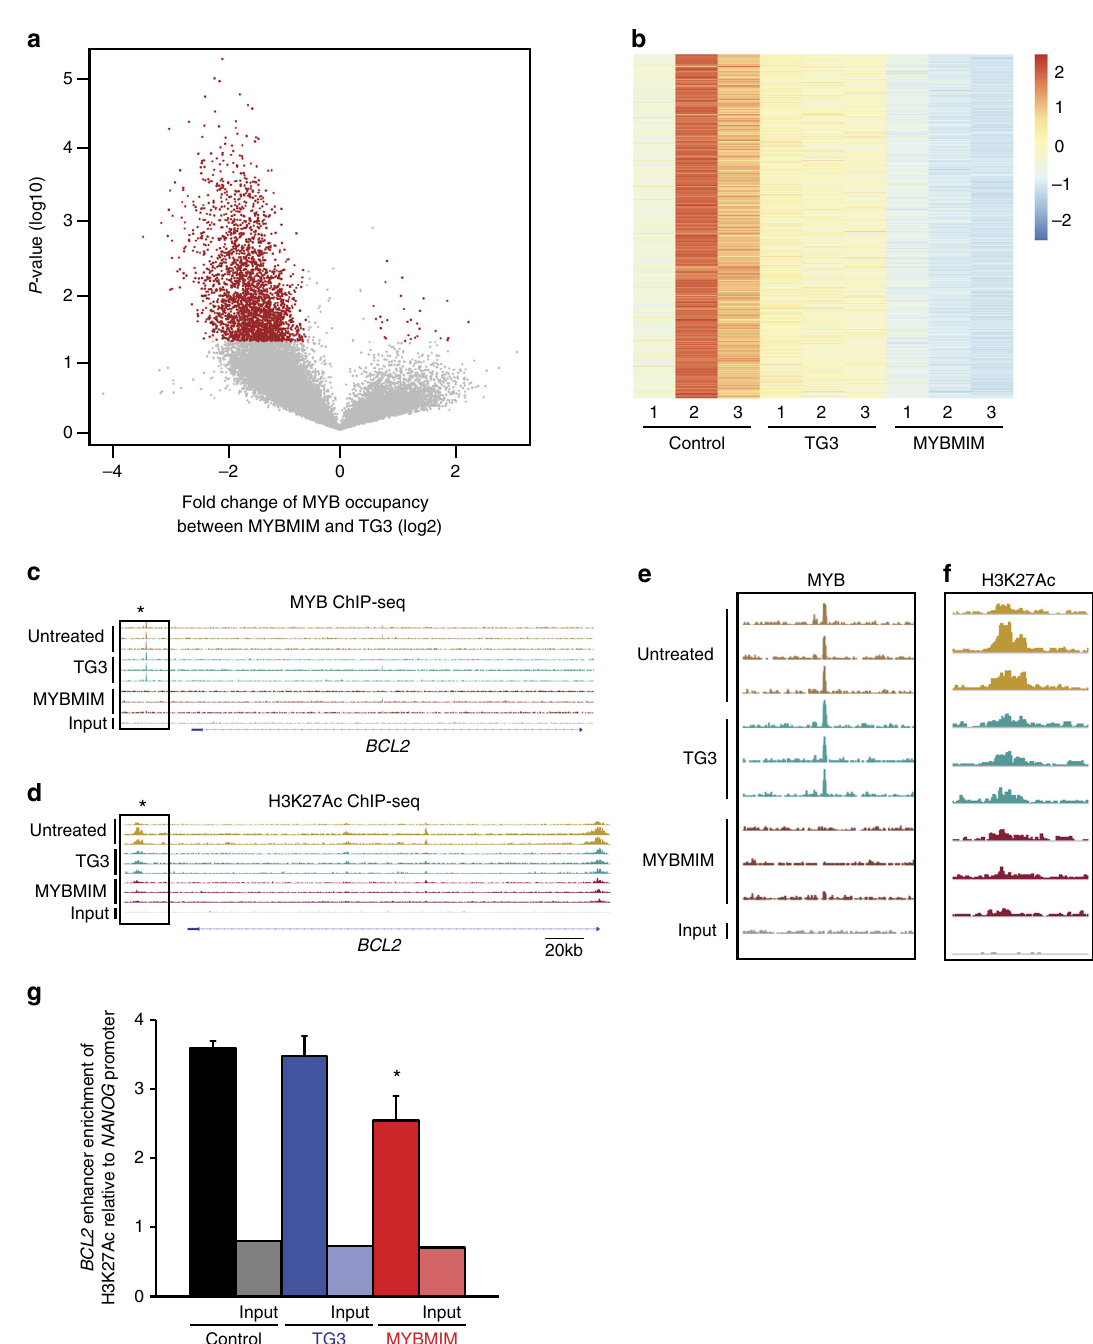
Fig. 3 MYBMIM suppresses the assembly of chromatin complexes. a Volcano plot of MYB occupancy in MV-411 cells treated with 20 µ M MYBMIM versus TG3 control for 6h, as analyzed by MYB ChIP-seq. p-values denote t-test statistical signi fi cance of 3 biological replicates. b Heatmap of changes in H3K27Ac occupancy of MV411 treated with 20 µ M MYBMIM versus TG3 control for 24h, as analyzed by ChIP-seq of three biological replicates. c Genome track of the BCL2 locus showing elimination of the MYB-bound enhancer (star) upon treatment with MYBMIM, but not control or TG3 treatment. d Genome track of the BCL2 locus showing elimination of the H3K27Ac-bound enhancer (star) upon treatment with MYBMIM, but not control or TG3 treatment. e Magni fi ed boxed area of MYB-bound enhancer peak shown in 3c. f Magni fi ed boxed area of H3K27Ac-bound enhancer peak shown in ( d ). g Analysis of relative enrichment of H3K27Ac at the BCL2 enhancer locus compared to NANOG , as measured by ChIP-PCR upon treatment with control PBS (black), 20 μ M TG3 (blue), and 20 μ M MYBMIM (red) for 24h. Error bars represent standard deviations of three biological replicates. * p = 8.6e – 3 when compared to untreated